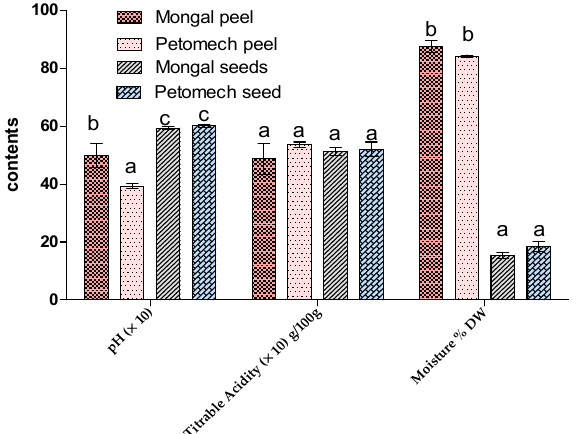
Figure 1. Physicochemical parameters of peels and seeds of Mongal and Petomech. The letters “a, b, c, d” indicate the different variations. Sticks with the same letters have statistically not different values. However, sticks with different letters have statistically different values .